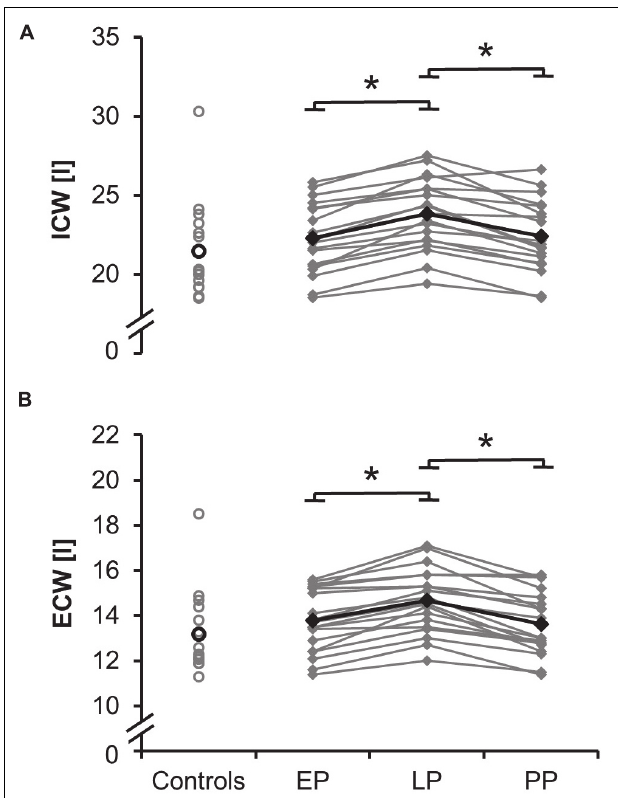
FIGURE 3 | Means (black) and individual data (gray) for the intracellular water ICW (A) and extracellular water ECW (B) for the non-pregnant controls and the pregnant women at the early (EP) and late (LP) stage of pregnancy as well as postpartum (PP) ( ∗ p <